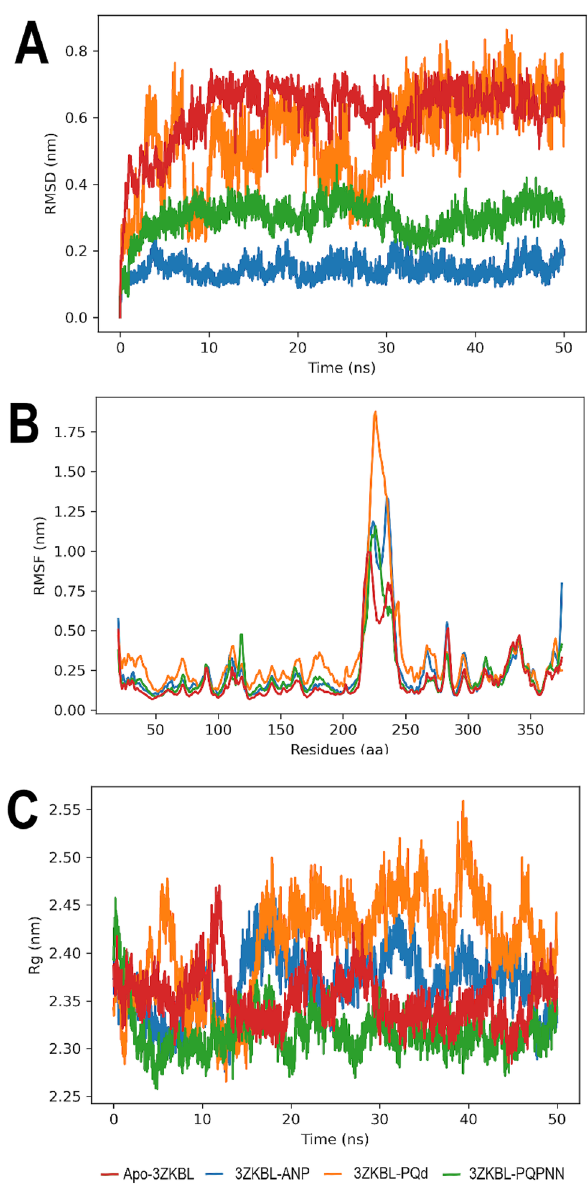
Figure 5. MD analyses of apo-3ZKBL and 3ZKBL complexed to ANP, PQd, and PQPNN. ( A ) RMSD values. ( B ) RMSF values. ( C ) Rg values. All performed with